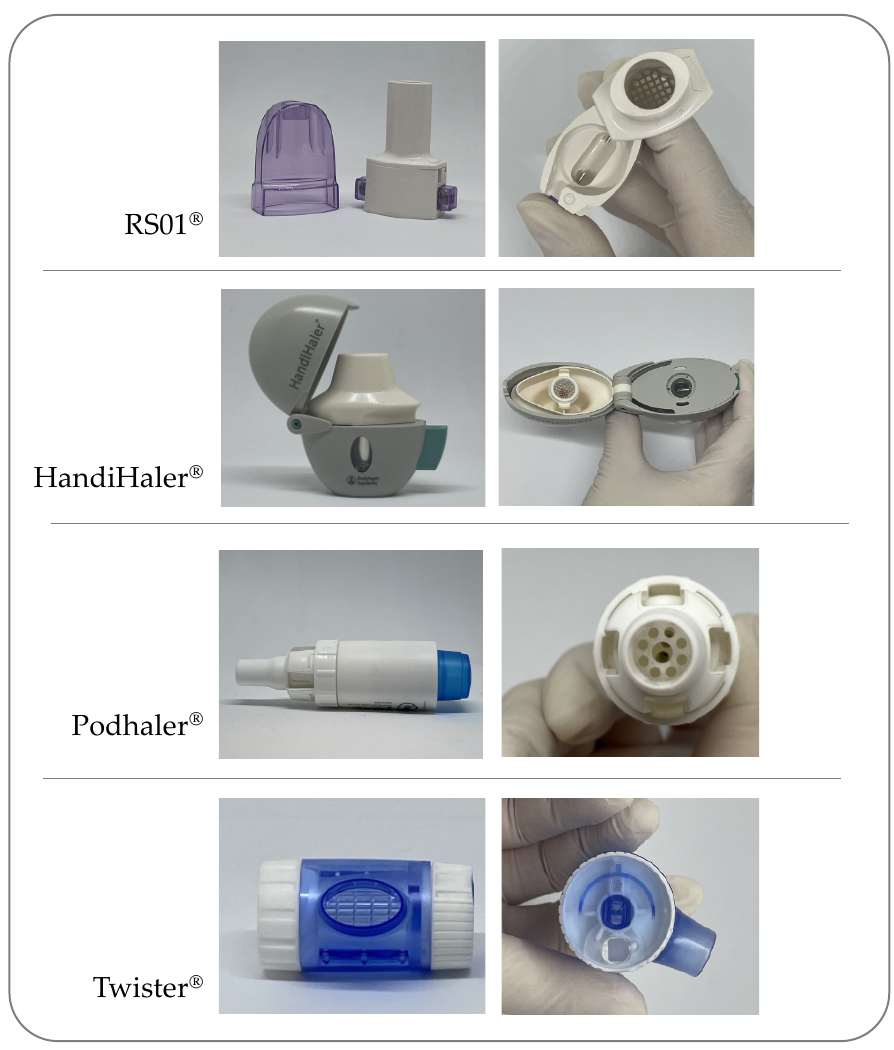
Figure 1. Different types of capsule-based dry powder inhalers with corresponding capsule perforation or opening mechanism; from the top: RS01, HandiHaler, Podhaler and Twister.